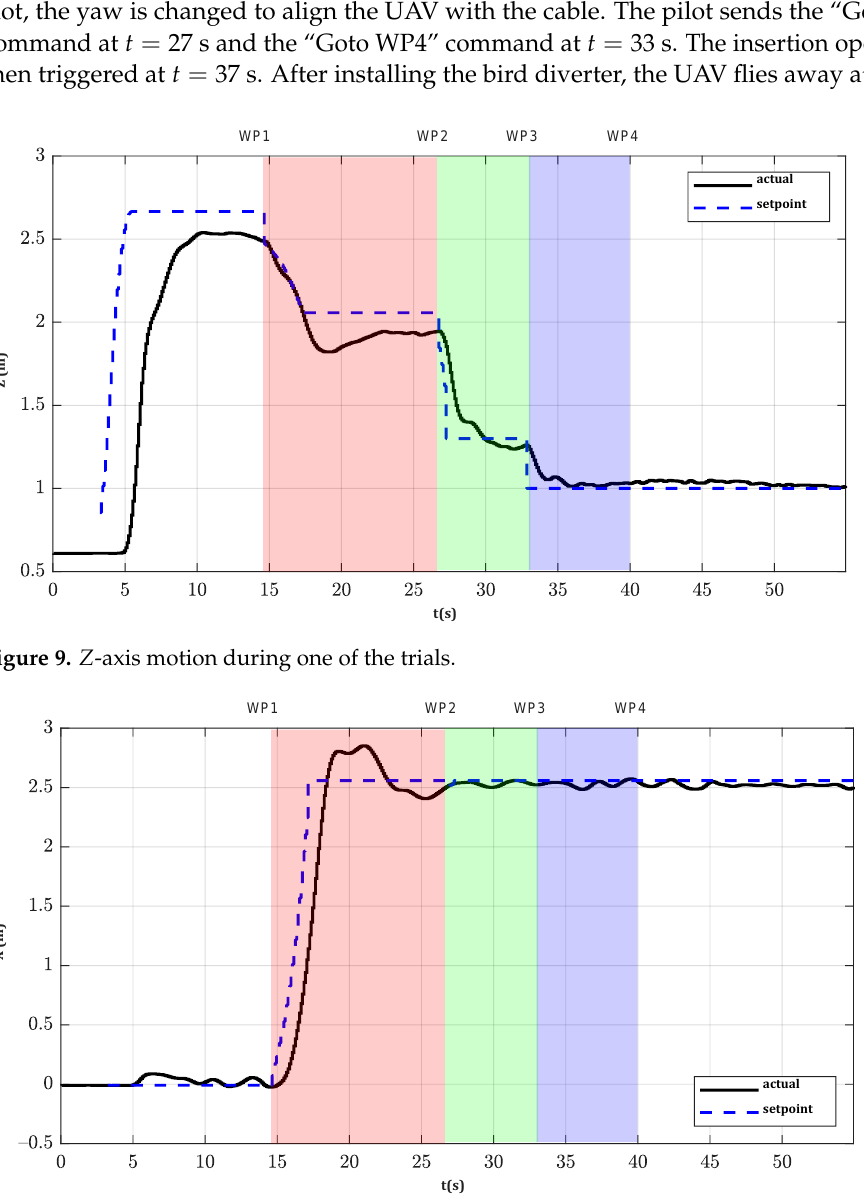
Figure 11. 𝑌𝑌 -axis motion during one of the trials.